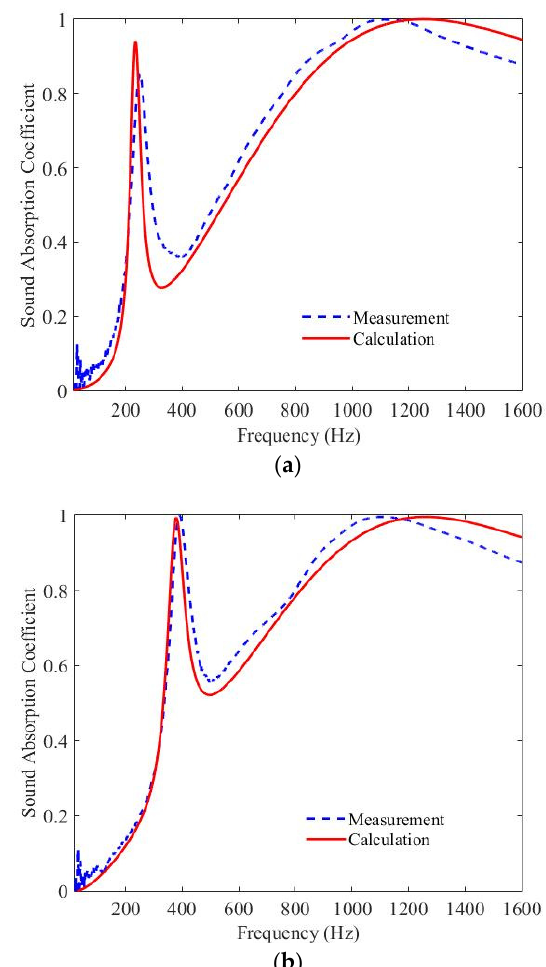
Figure 6. Sound absorption coefficient of the composite absorber for ( a ) HPSET 1 and ( b ) HPSET 2 (see Table 2). Red solid line: calculation by inversion method; Blue dashed line: direct measurement.